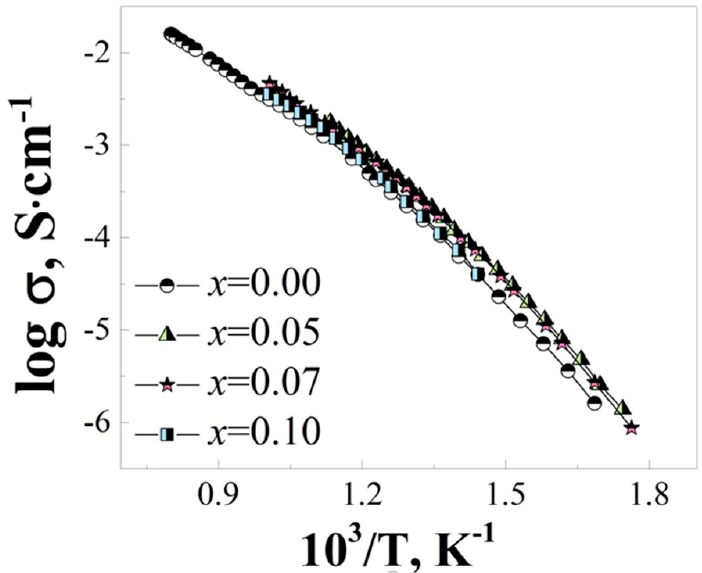
Figure 6. Temperature dependence of bulk electrical conductivity for the (1- x )Gd 2 Zr 2 O 7 · x MgO com- posites.